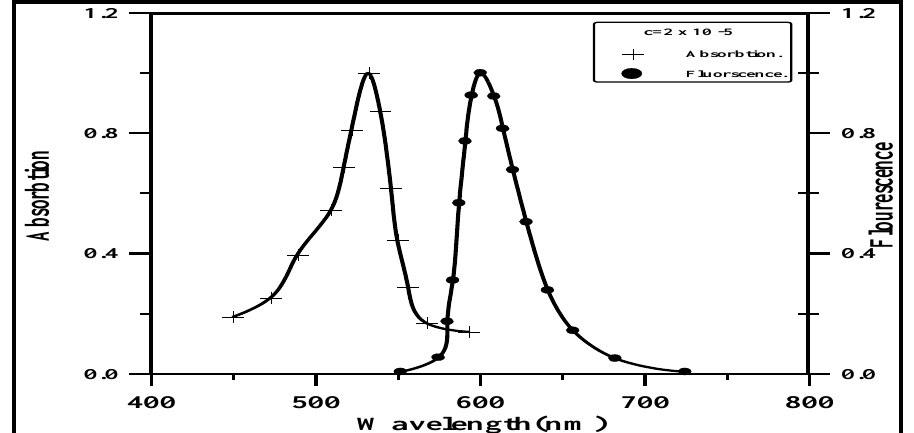
Fig. 2: The absorption and fluorescence spectrum of R6G dye doped PMMA for concentration 2×10 -5 mol/ ℓ at thickness (25.8μm).